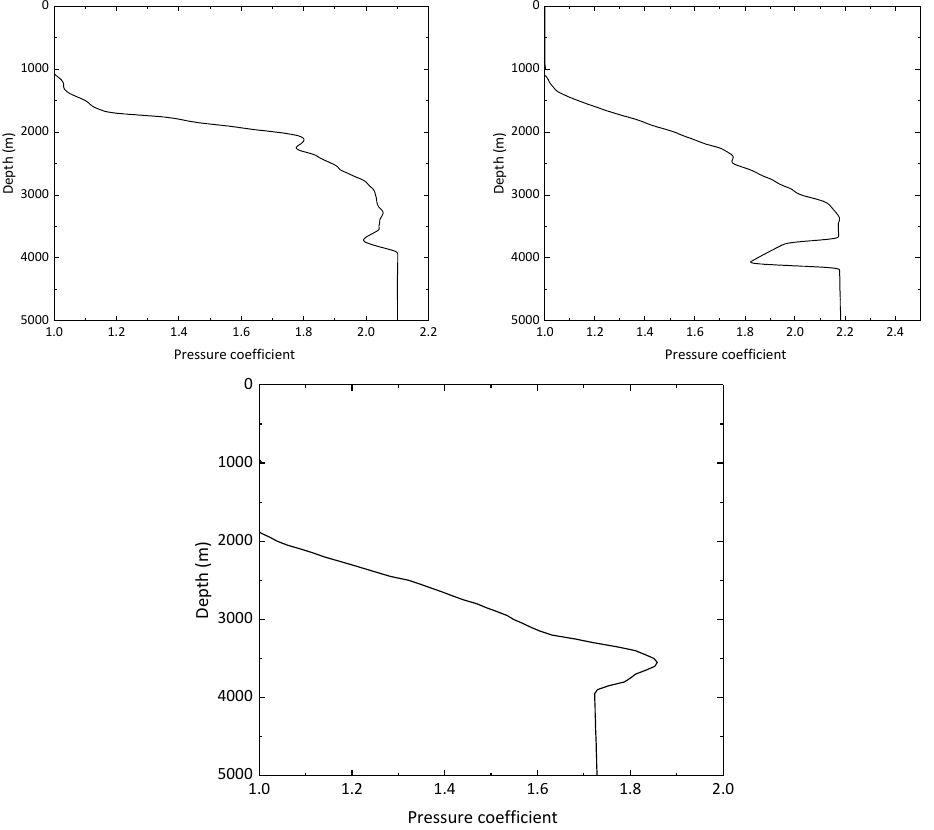
Figure 6. Pressure profile of wells X-1, X-2, and X-4 .